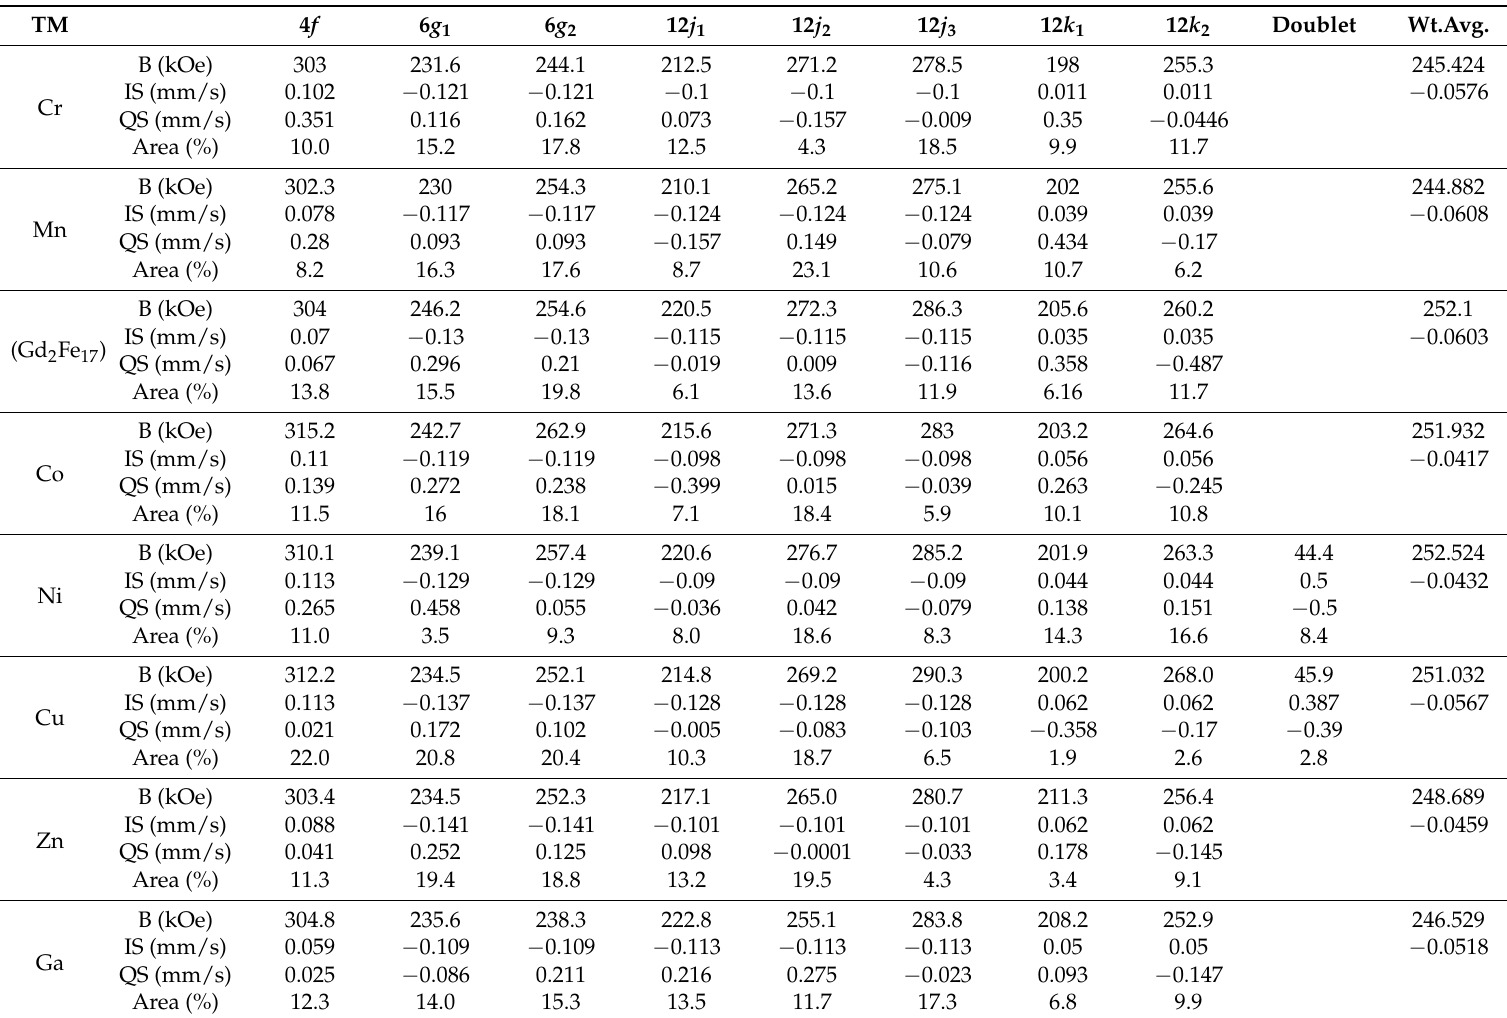
Table 5. RT Mössbauer hyperfine parameters for Gd 2 Fe 17 and Gd 2 Fe 16 Ga 0.5 TM 0.5 (TM = Cr, Mn, Co, Ni, Cu, Zn, and